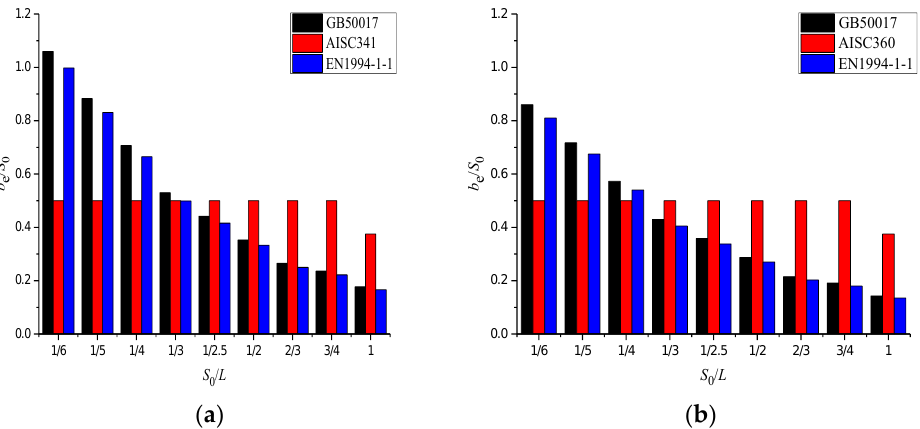
Figure 8. Comparison of effective flange width ratios (b e /S 0 ) in the negative bending moment region. ( a ) L 1 = L 3 = L 2 = L ; ( b ) L 1 = L 3 = 1.5 L 2 = 1.5 L.